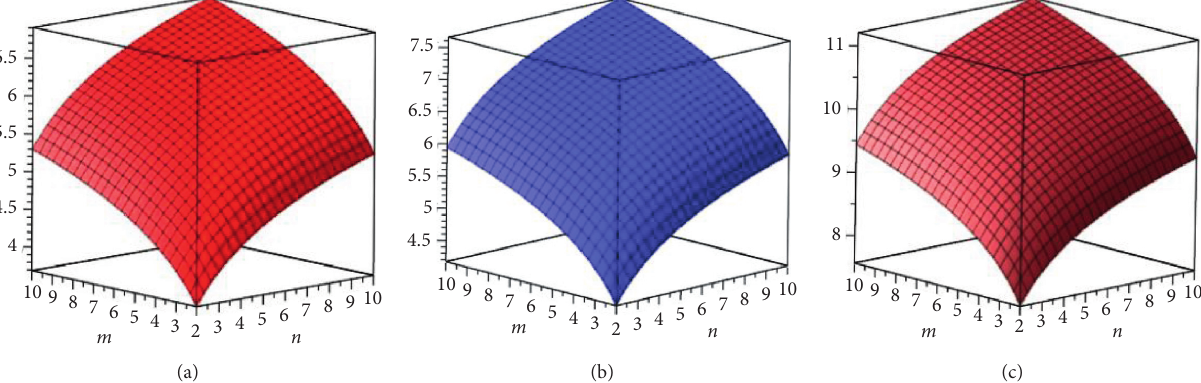
Figure 11: (a) The redefined first Zagreb entropy; (b) the redefined second Zagreb entropy; (c) the redefined third Zagreb entropy.